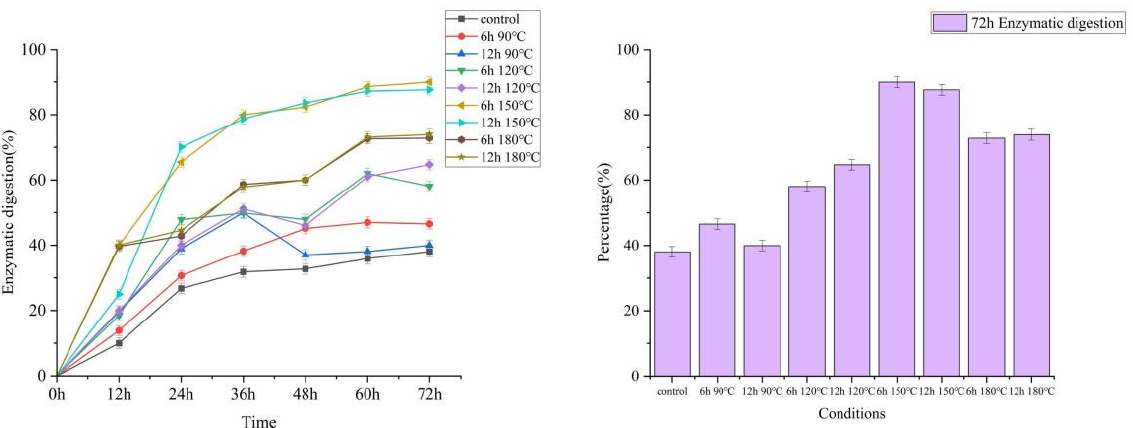
Figure 7. Enzymatic digestion of pretreated WS residues by DES.